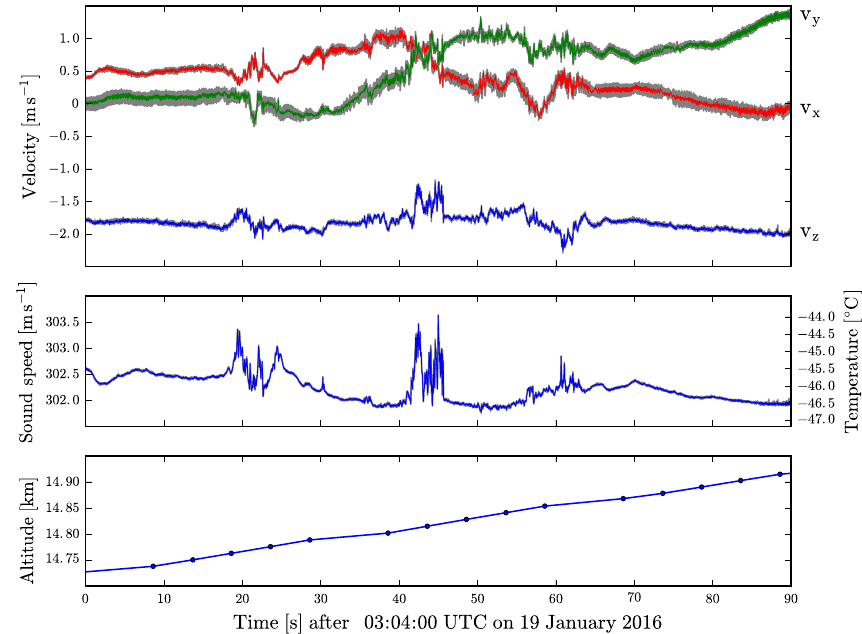
Figure 7. From top to bottom: plots (versus time) of wind velocity, air sound speed vs. temperature, and gondola altitude. The data in the upper two plots were measured by TILDAE’s sonic anemometer. The raw 200Hz measurements are shown in gray, and a three-point median- filtered version is overplotted in color. The ˆ z axis corresponds to the vertical; thus, the negative v z values indicate the downward flow of air (in the anemometer’s frame of reference) during the balloon’s ascent. The bottom plot was generated from GRIPS’ GPS data, which were recorded approximately once every 6 or 12s.